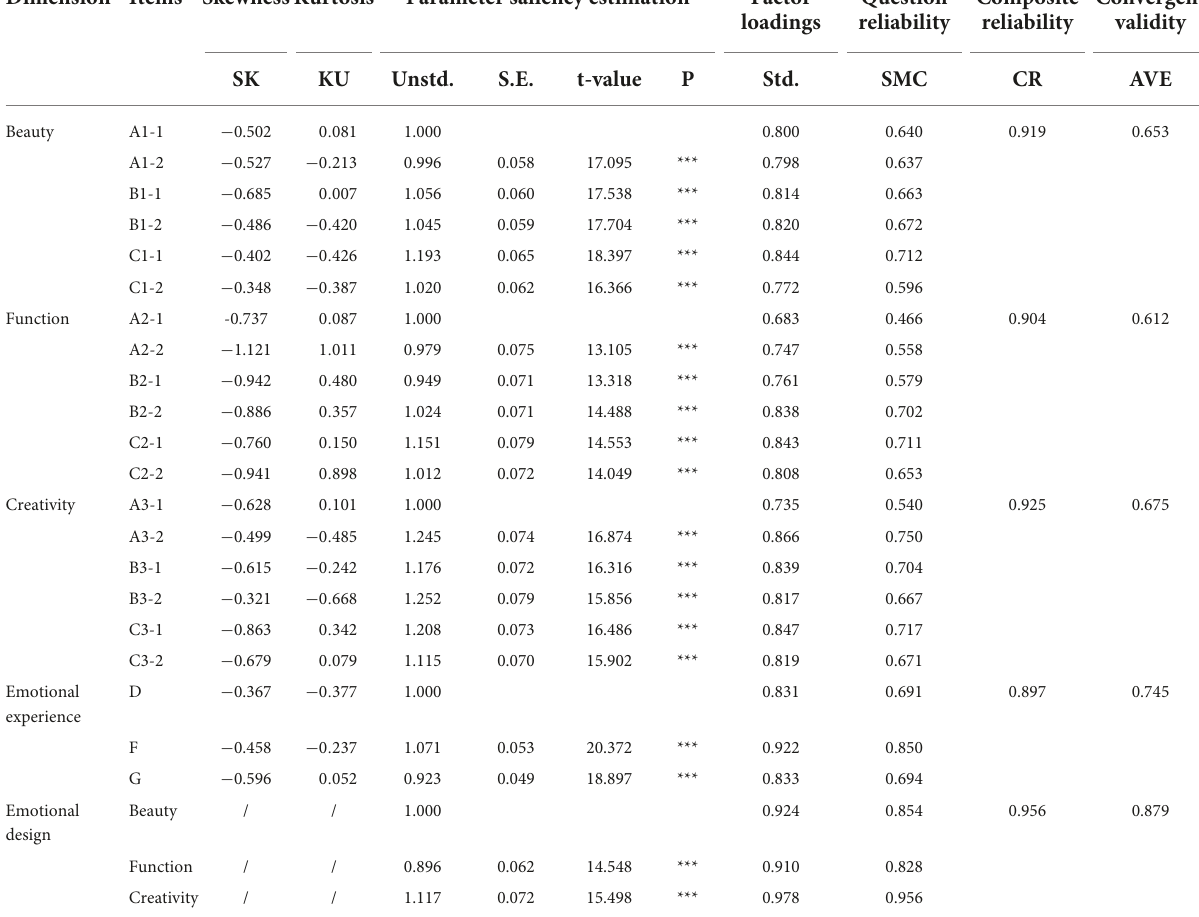
TABLE 4 The research model confirmatory factor analysis table. Dimension Items SkewnessKurtosis